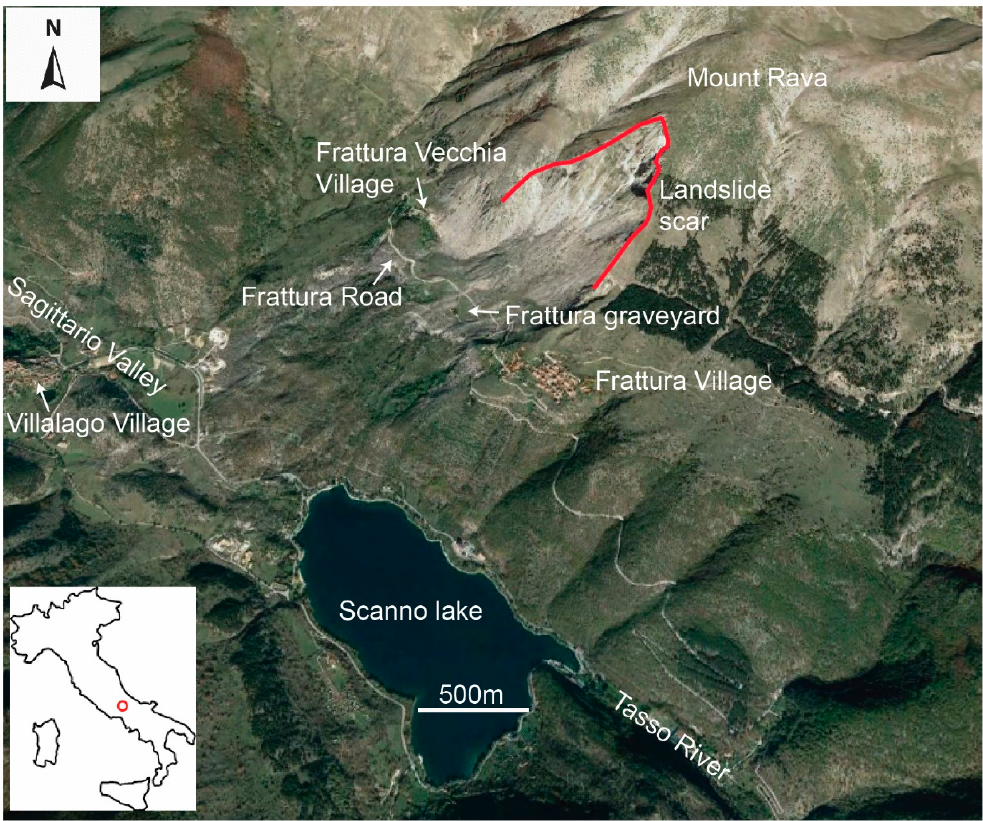
Figure 1. SW flank of the Mount Rava with the Scanno landslide and landslide scar (in red) highlighted. Location of the study area is shown in the inset.